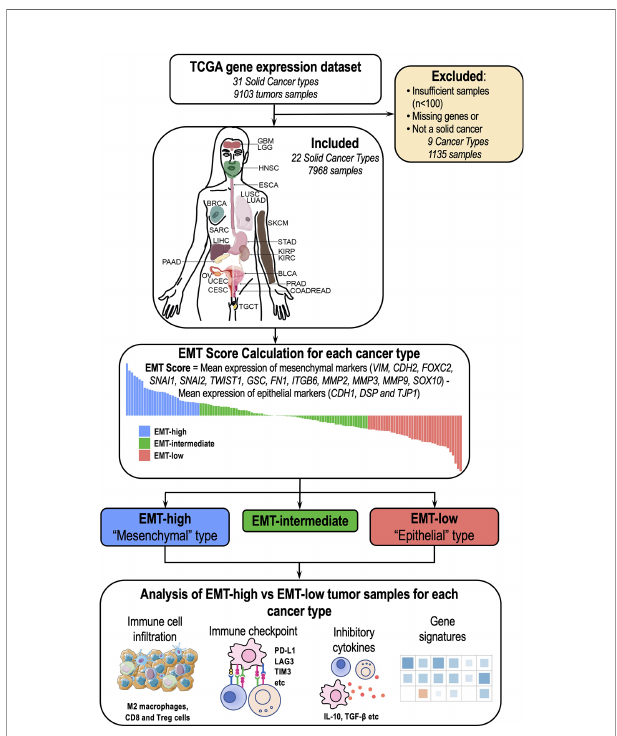
FIGURE 1 | Overview of the study: A total of 22 cancer types (7,968 samples) were included in the study. Epithelial – mesenchymal transition (EMT) score was calculated for each of these 22 cancer types, and different aspects of tumor immune microenvironment (TIME) were analyzed between EMT-high and EMT-low